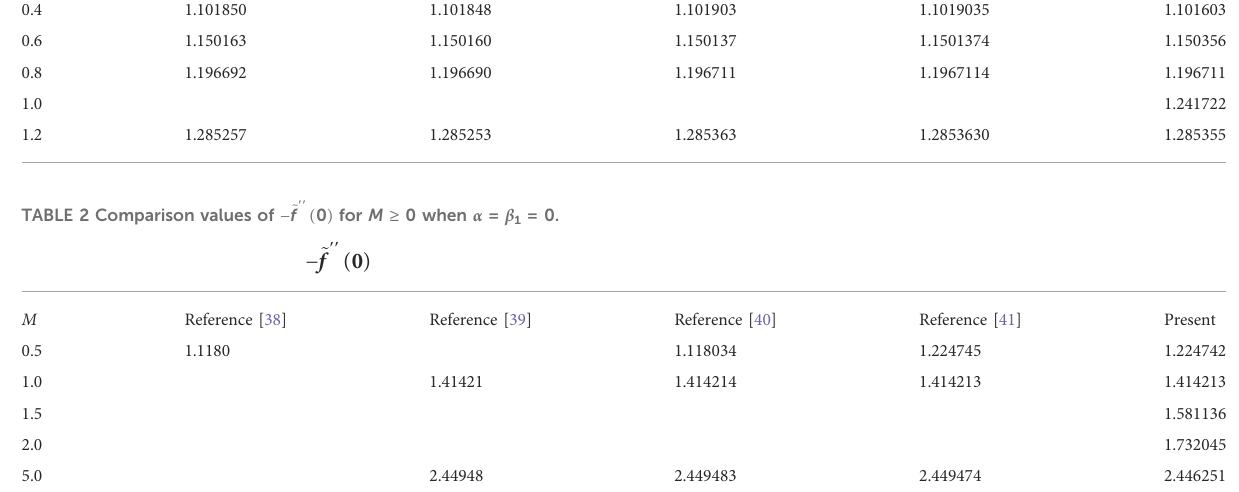
99 ( 0 ) for β 1 ≥ 0 when α = M = 0.